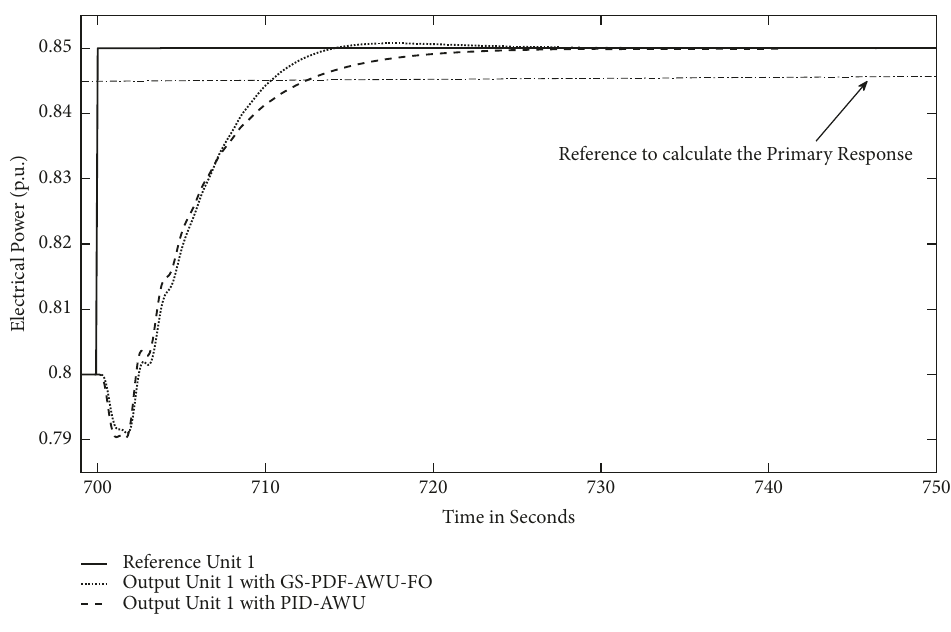
Figure 11: Step responses of PID and GS-PDF-FO, both with antiwindup, six operational units, and h=1.